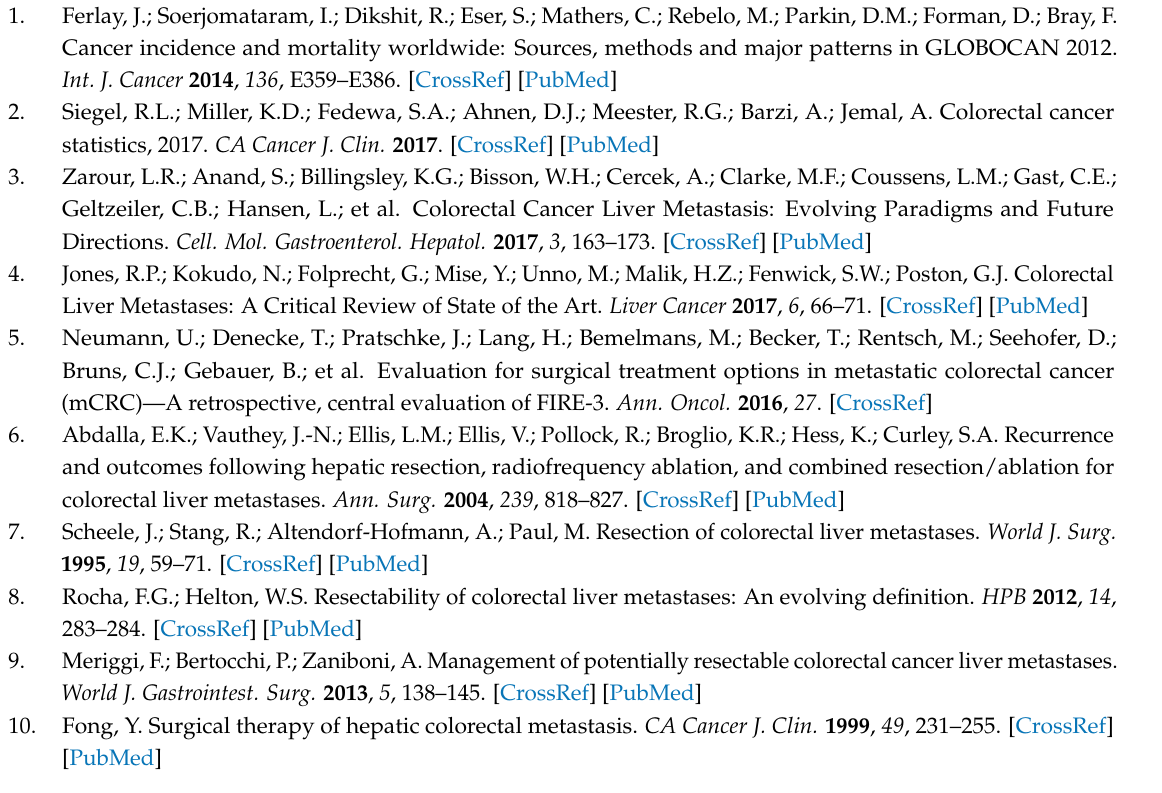
Figure S1: Initial osteopontin serum levels and disease specific characteristics, Figure S2: Postoperative osteopontin serum levels and disease specific characteristics, Table S1: Serum levels of laboratory